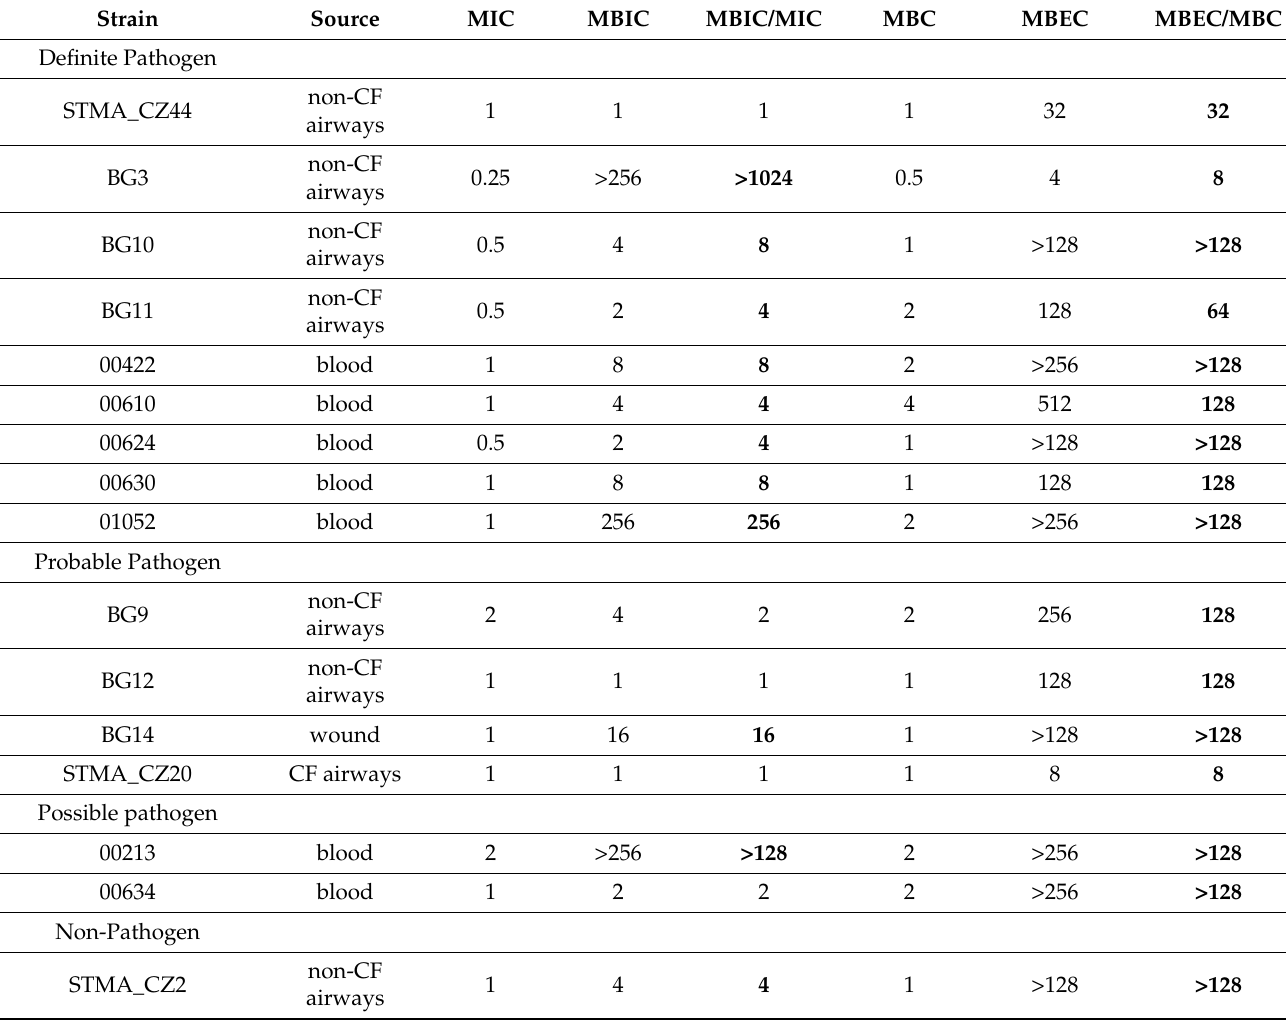
Table 4. In vitro susceptibility of preformed biofilms by S. maltophilia to levofloxacin. Minimum Biofilm Inhibitory Concentration (MBIC) and Minimum Biofilm Eradication Concentration (MBEC) values, expressed as µ g/mL, were measured for a set of strains representative of different pathogenic roles and sources. Statistically significant MBEC/MBC values (significance set at >2) are in bold. According to Stepanovi´c et al. [24], all strains were “strong-producers” except for BG12